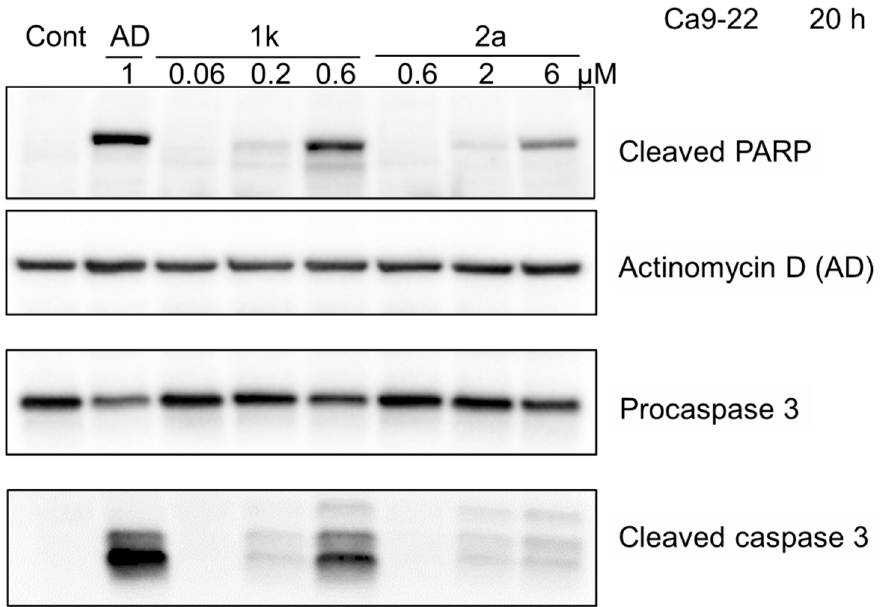
Figure 5. Cleavage of PARP and procaspase 3 in Ca9-22 cells by 1k , 2a, and actinomycin D(AD). Cells were treated without (control) or with 1 µM actinomycin D or the indicated concentrations of 1k and 2a in the presence of the DMSO vehicle (0.1%).